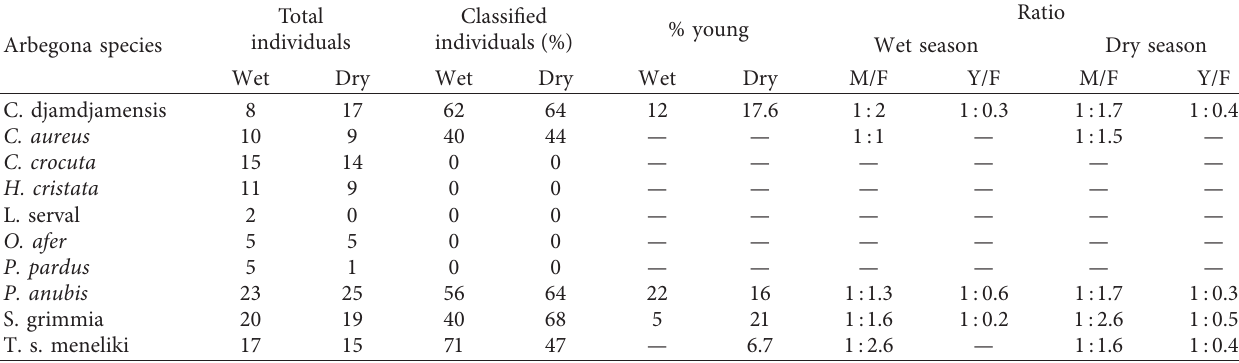
Table 5: Populations structure and ratio of large wild mammals at Geremba Mountain, southern Ethiopia. Arbegona